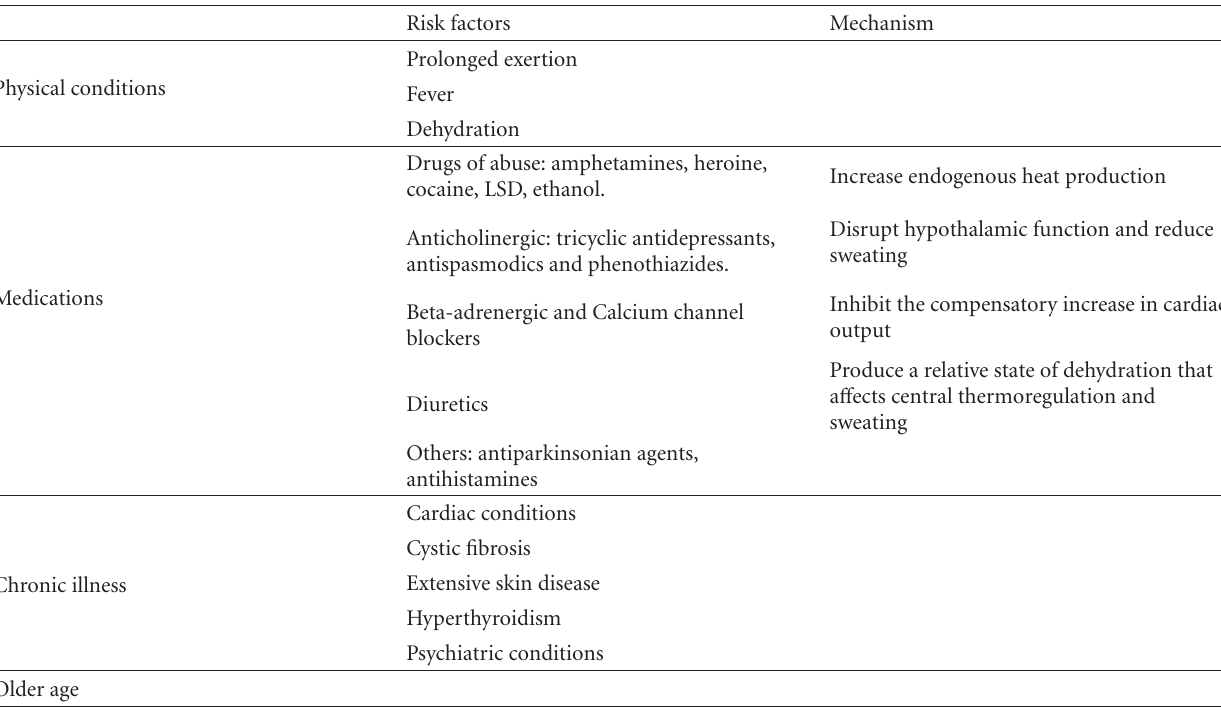
Table 1: Conditons contributing to the risk of heat